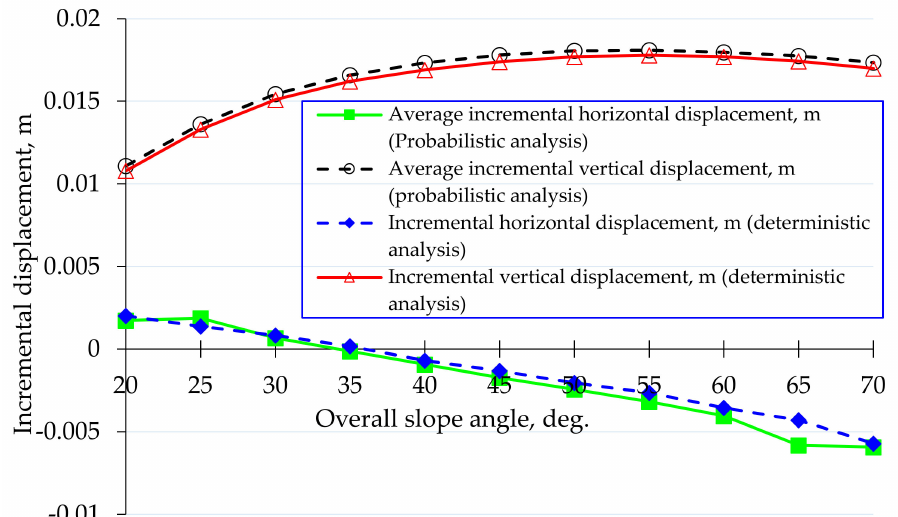
Figure 8. Incremental displacements at various overall slope angles (deterministic vs. probabilis- tic analysis).